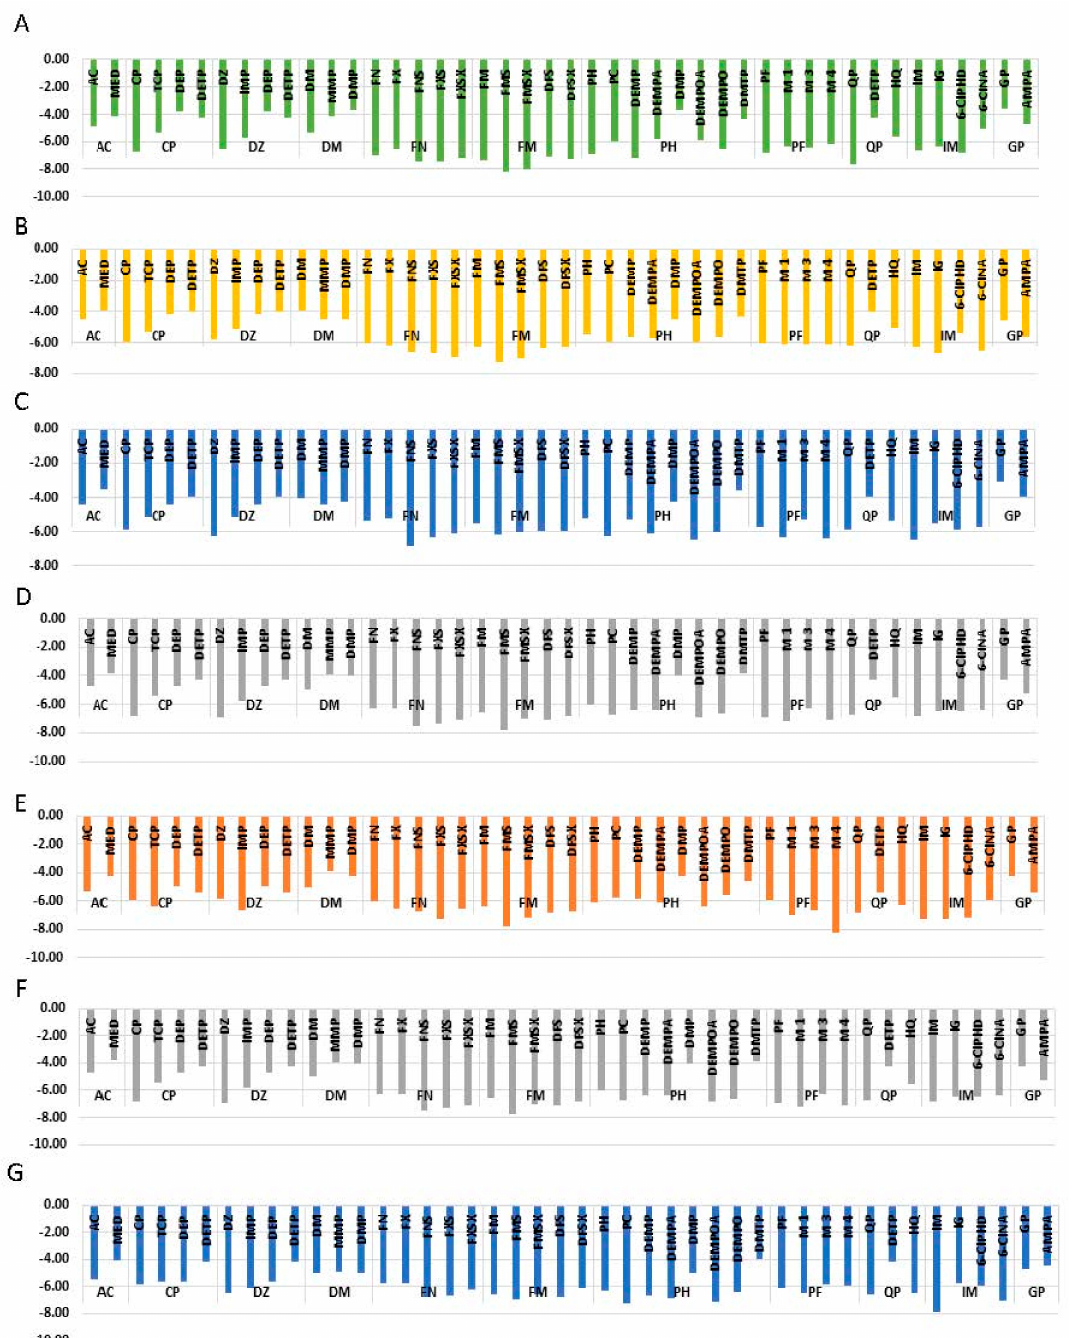
Figure 3. Graphical representation of variation of binding energies kcal/mole (BE) of eight different proteins, i.e., ( A ) AChE, ( B ) Adenosine monophosphate (AMP) Activated Protein Kinase (AMPK), ( C ) Apoptosis Signaling Kinase 1 (ASK1), ( D ) Glutathione S Transferase (GST), ( E ) PKC, ( F ) GLS, and ( G ) CP450 with eleven pesticides and their metabolites. According to Figure 3, when the binding energy of AC pesticide (average bind- ing energy = − 4.05 kcal/mol) compared with its metabolite MED (average binding energy = − 3.86 kcal/mol), AC has a higher binding affinity with all the proteins con- sidered. The number of residues involved in AC binding is higher when compared with metabolites (TCP, DEP, and DETP), CP has the highest binding affinity, except in one